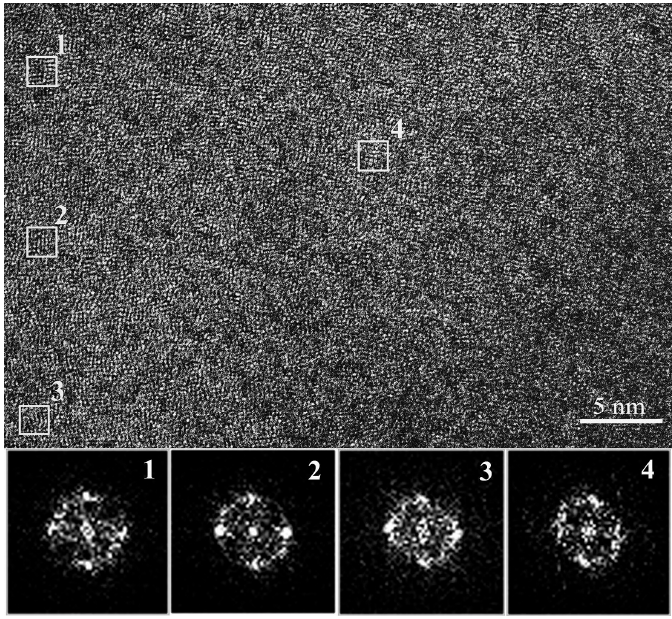
Figure 10. High-resolution transmission electron microscopy (HREM) image of the deformed structure. Bottom of the figure: results of the fast Fourier transformation (FFT) of the marked regions. Figure numbers at the bottom correspond to the numbers of the marked regions.